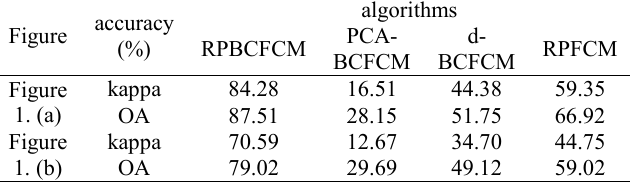
Figure 2. Comparison of segmen tation results. Table 1 Accuracy evaluation of segmentation